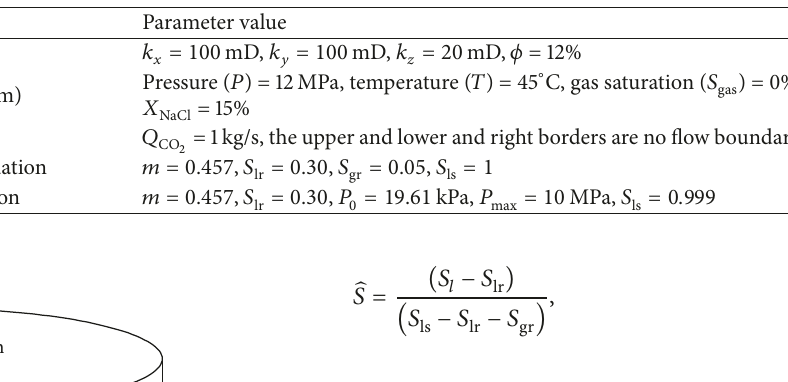
Table 2: The parameters of the radial model.